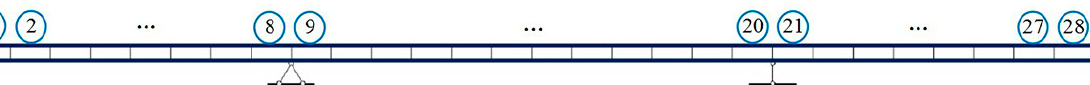
. Different damage levels are simulated